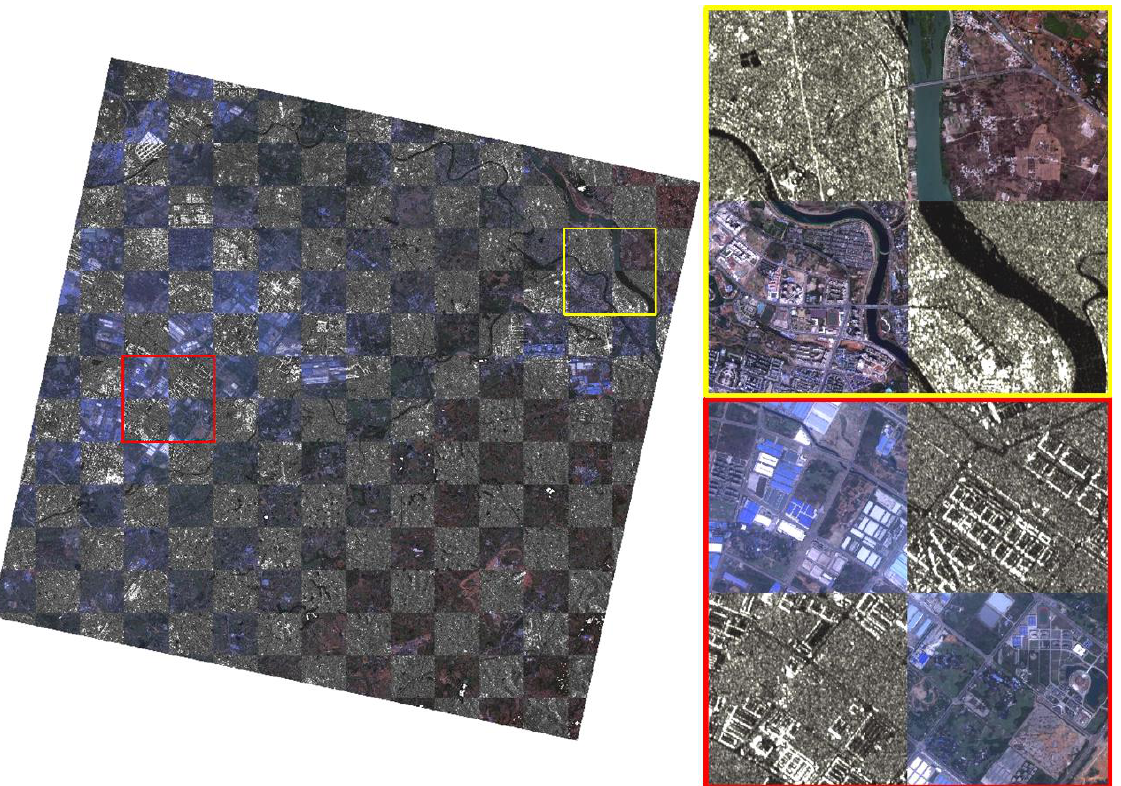
Figure 8. registration checkboard result of